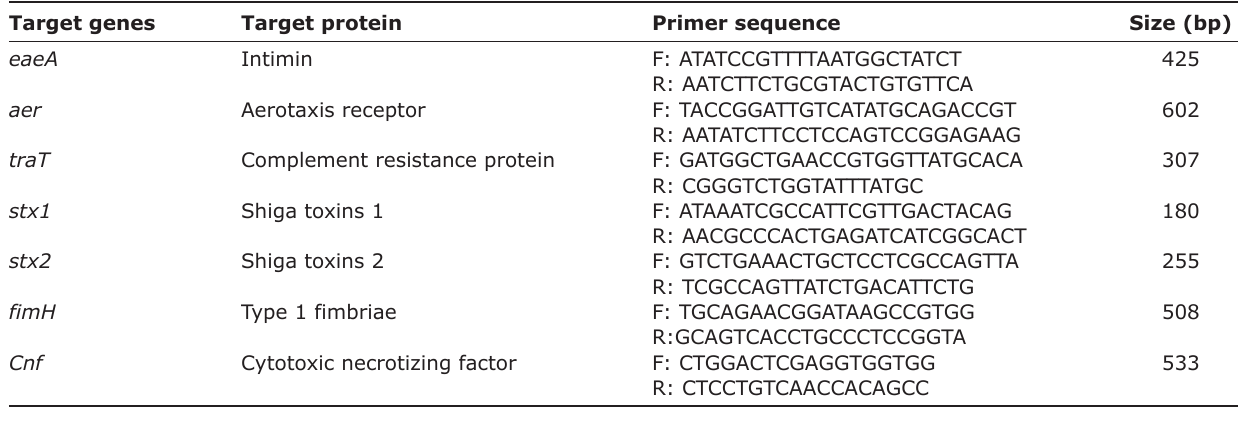
Table-2: Oligonucleotide primers used to detect virulence